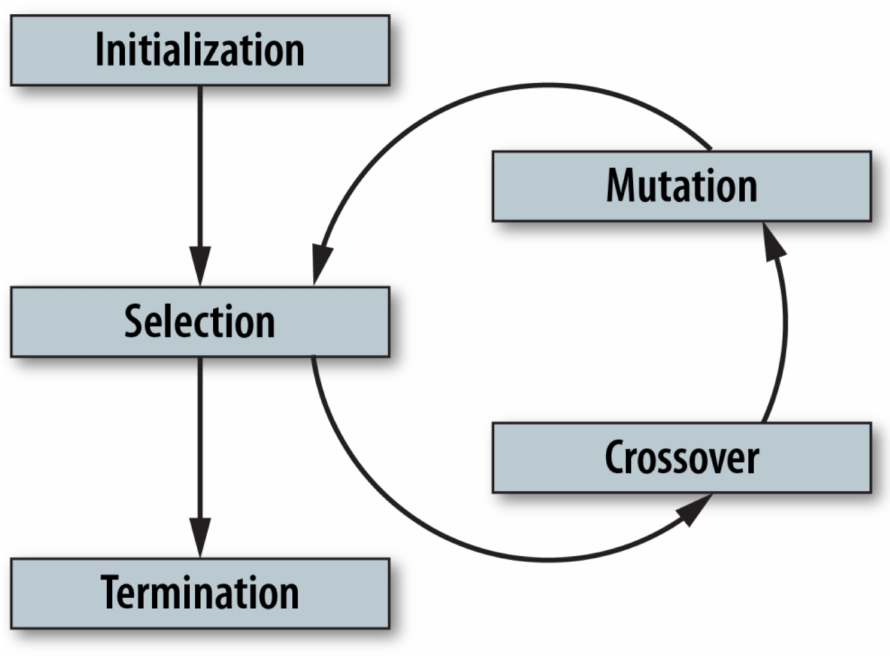
Figure 1. A flow diagram for a standard